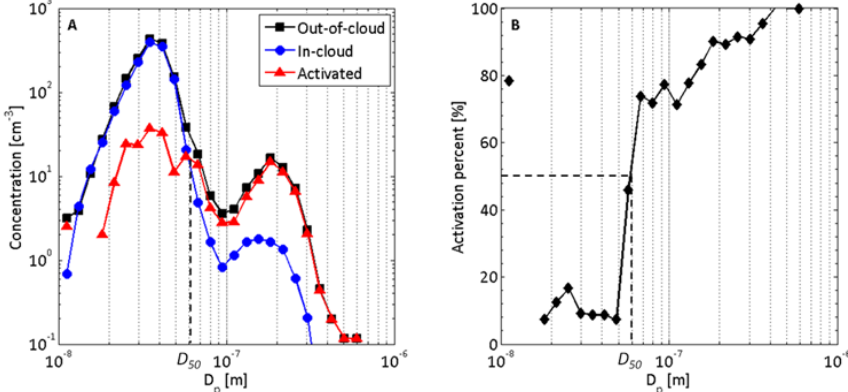
Fig. 16. Median size distributions of out-of-cloud, in-cloud and activated particles (A) and activation percent as a function of particle size (B) . The dashed lines show the activation diameter D 50 (out-of-cloud minus in-cloud size spectra). Out-of-cloud and in-cloud size distributions are medians over corresponding times. Activation percent (B) is defined as activated divided by in-cloud size spectra.